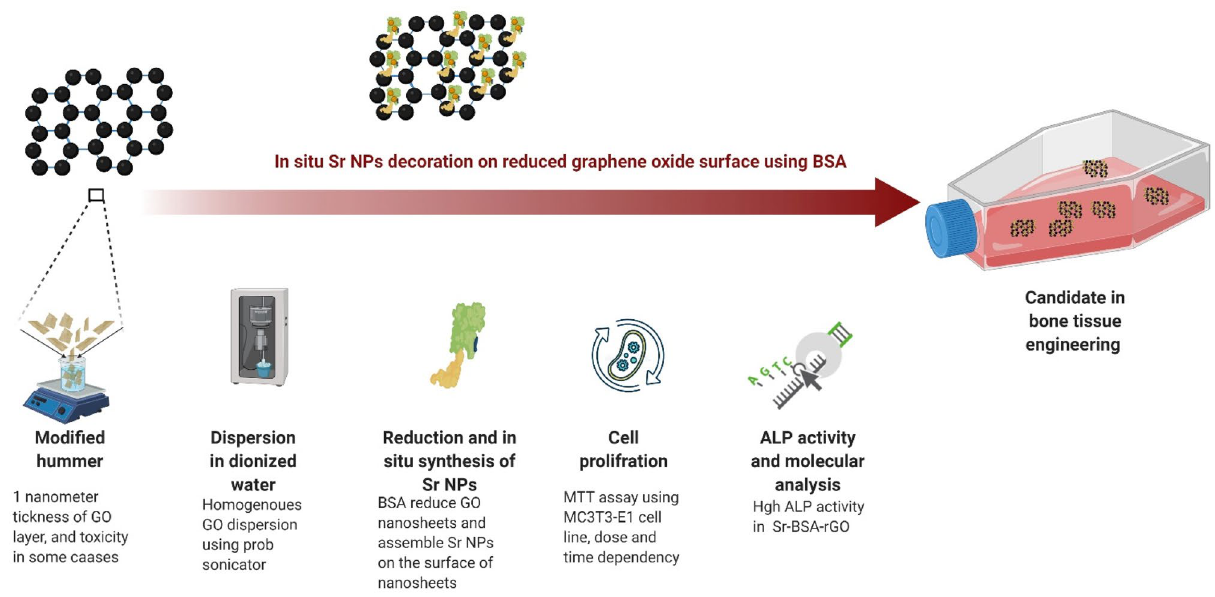
Figure 1. Sr-BSA-rGO nanosheets in bone tissue engineering. This illustration demonstrates the synthesis and application process from chemistry lab to molecular genetic lab, that was employed in this